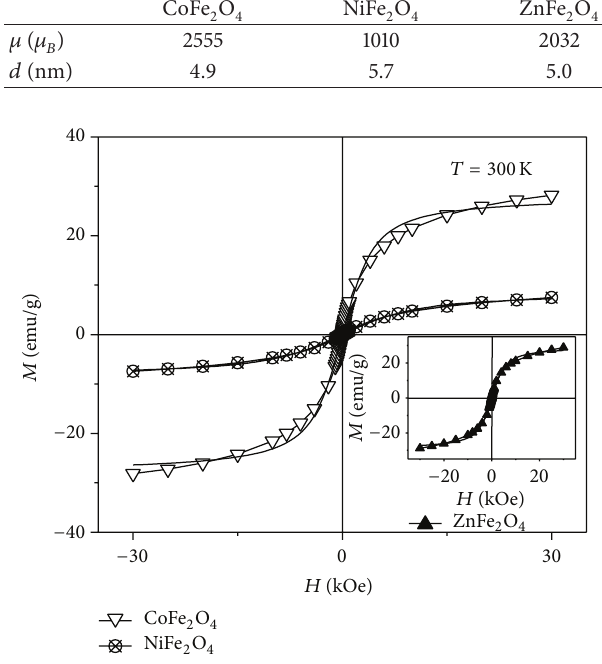
Figure 8: Experimental 𝑀(𝐻) dependences obtained at 𝑇 = 300 K (symbols) and results of their fitting by Langevin function (solid